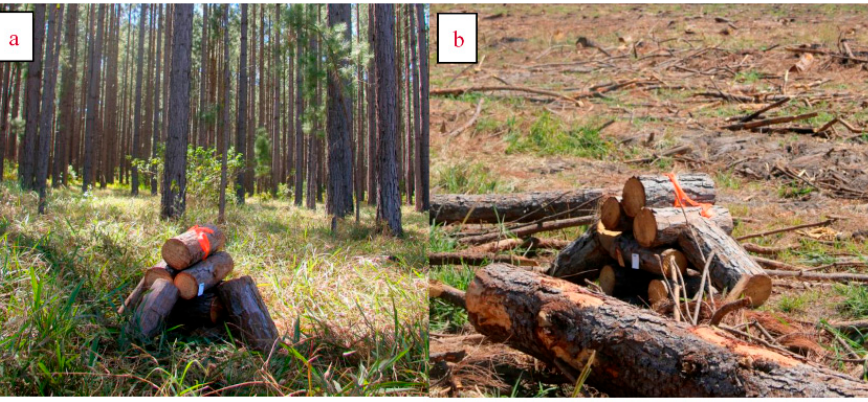
Figure 1. Set up of the local substrate availability in the unharvested ( a ) and harvested ( b ) pine